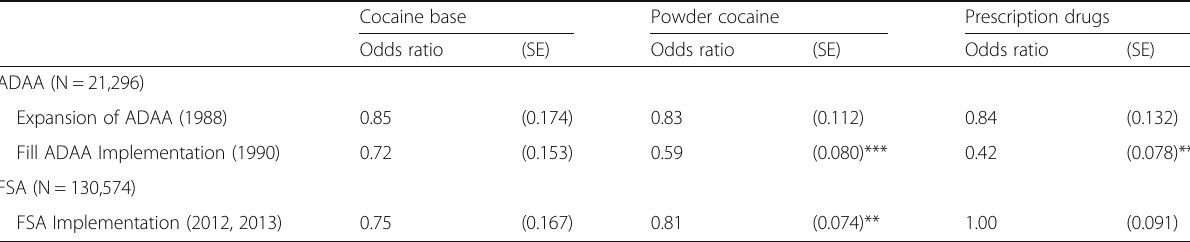
Table 2 Change in drug use post-ADAA and post-FSA by form and type of drug Cocaine base Powder cocaine Prescription